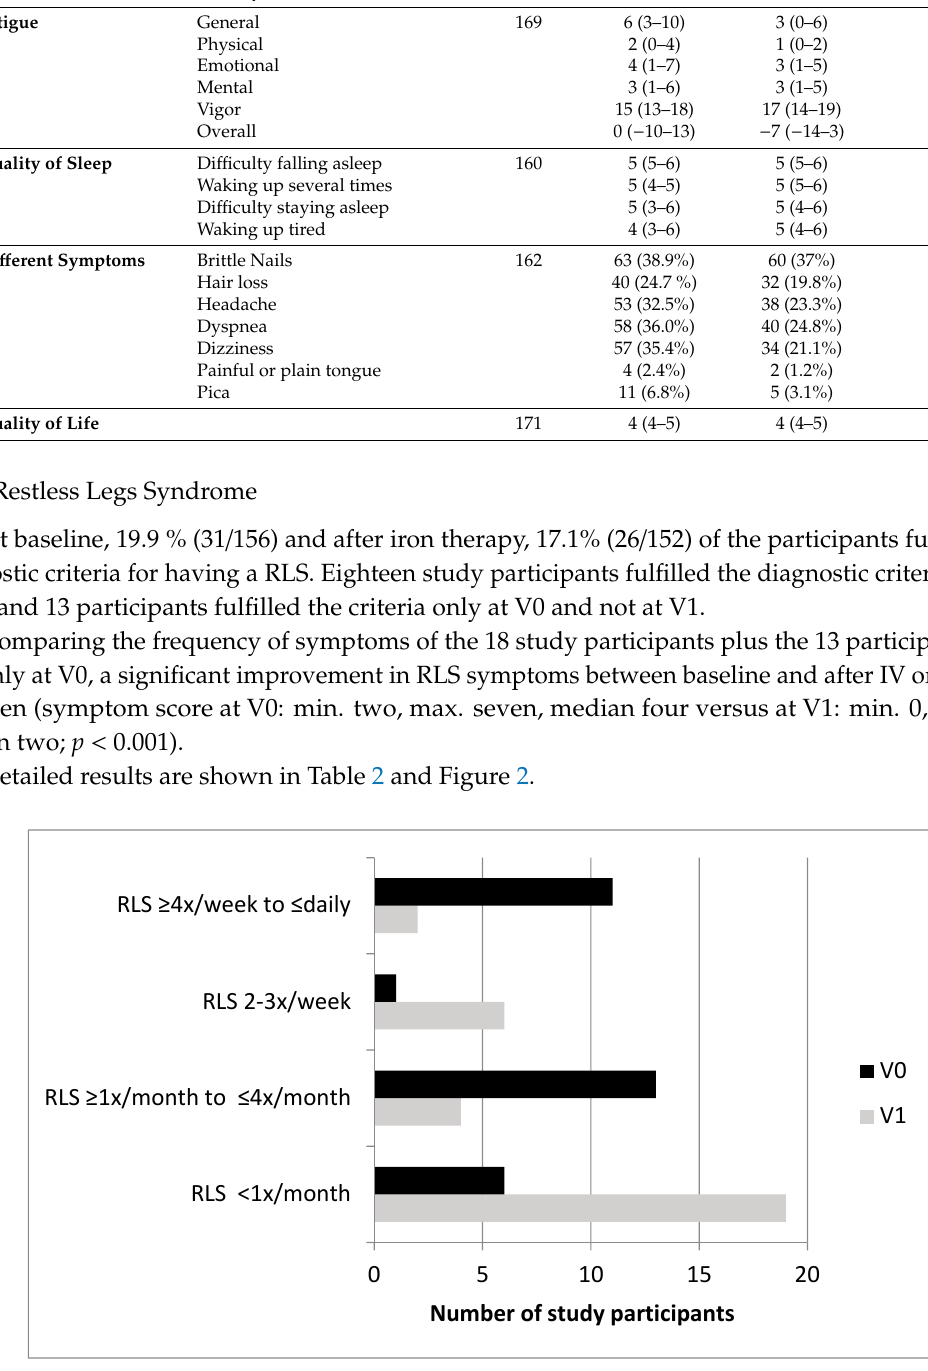
Figure 2. Bar diagram showing the number of study participants (x-axis) who indicate the frequency of their restless legs syndrome (RLS) at the two time points before (V0, dark bars) and after IV or oral iron therapy (V1, bright bars) on the y-axis. The decrease in the RLS occurrence between V0 and V1 was statistically significant ( p < 0.001, n =